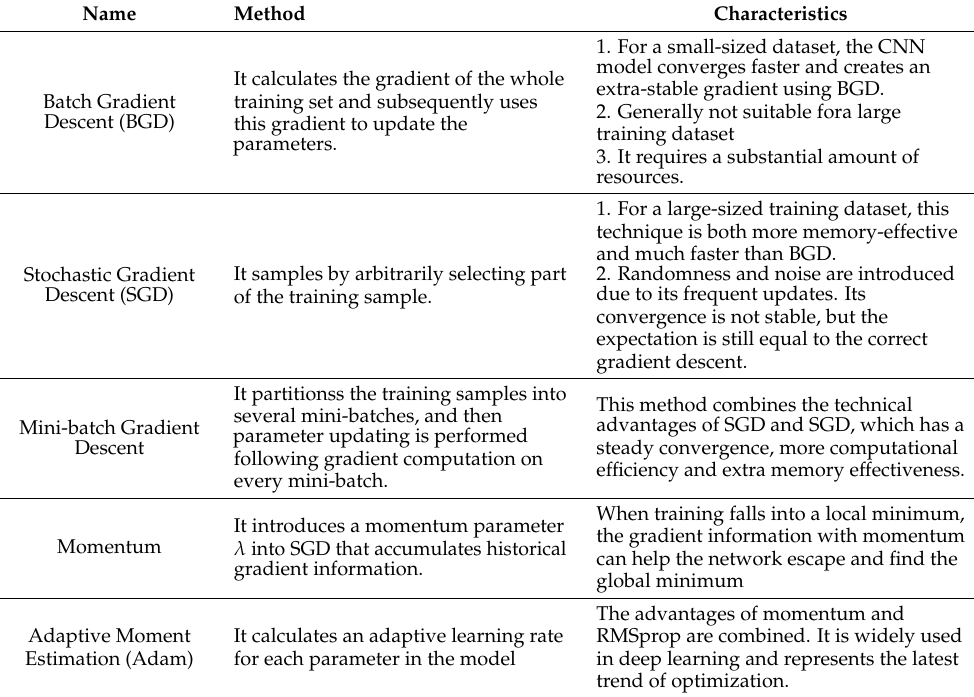
Table 2. Different optimizers for CNN